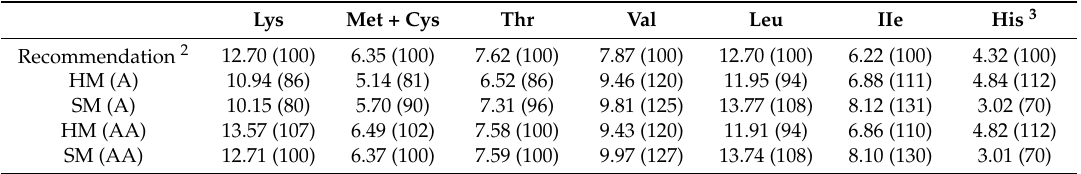
Table 3. Recommended and achieved AA supply 1 (in g/kg as-fed resp. in percent of the recommendation) in piglet diets under study.